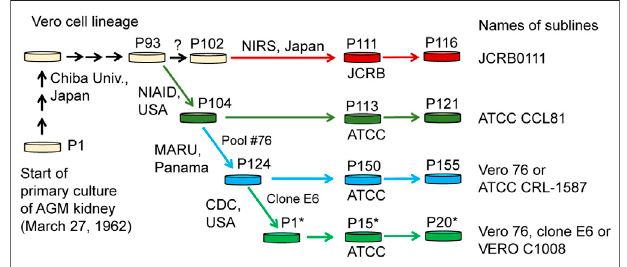
FIGURE 1 | History of Vero cell lines. Figure is adopted from Sakuma et al. (2018) under a Creative Commons Attribution 4.0 International license.